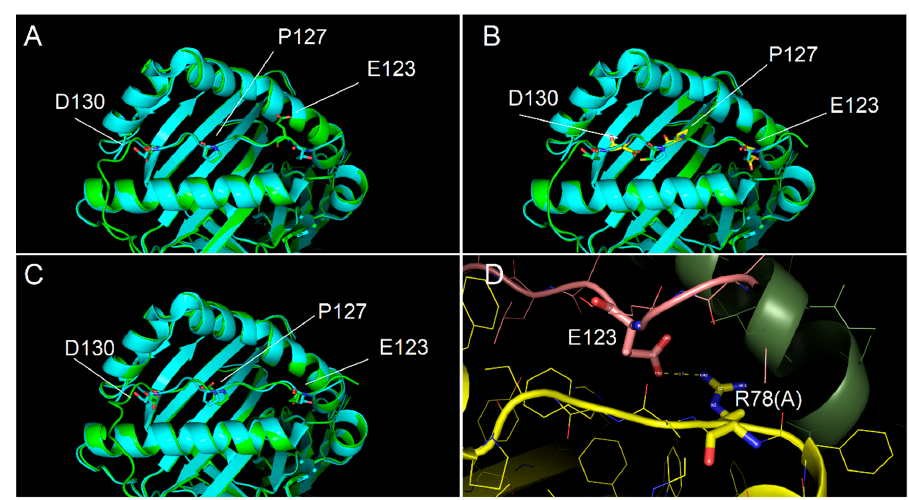
Figure 5. Interaction of p13 with DQ8 binding site. ( A – C ) Interaction models obtained with the alignment conditions named model 1, model 2 and model 3, respectively. Cyan and green models overlapped showed the conformity of experimental (PDB code 2NNA) and modelled structures, respectively, of the DQ8 protein shown with backbone ribbon and of experimental peptide and modelled p13. Labels identify key residues of the modelled peptide, differently positioned in the binding groove as for the different alignment used. In model 3, all key residues of p13 are very close to the position of the corresponding residues of the template peptide in the anchor sites. ( D ) Detail of the salt bridge interaction between Arg78 of the DQ8 alpha chain and E123 of p13 observed for model 3.